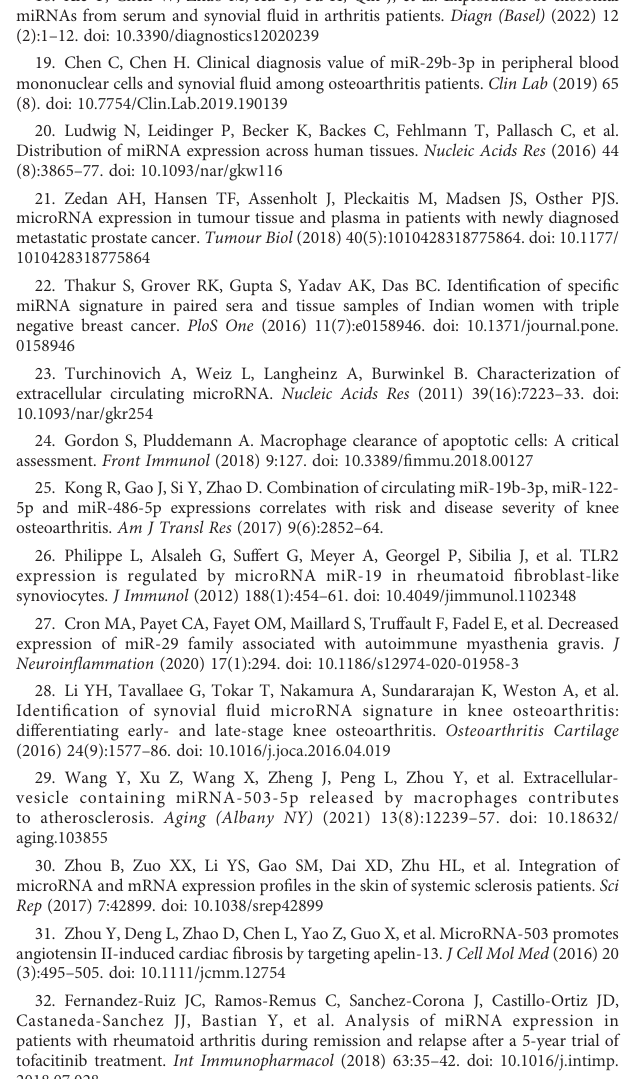
SUPPLEMENTARY FIGURE 4 MiRNA-gene network analysis illustrating the effects of miRNA deregulation in RA and